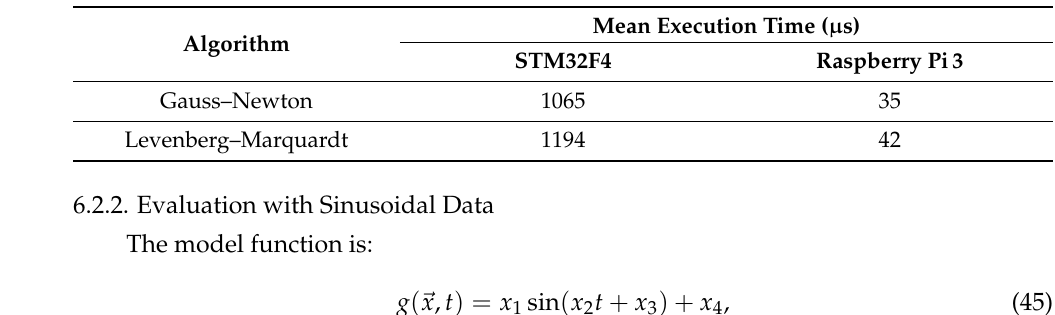
Table 4. Mean execution time of the Gauss–Newton and Levenberg–Marquardt methods (per iteration) using exponential